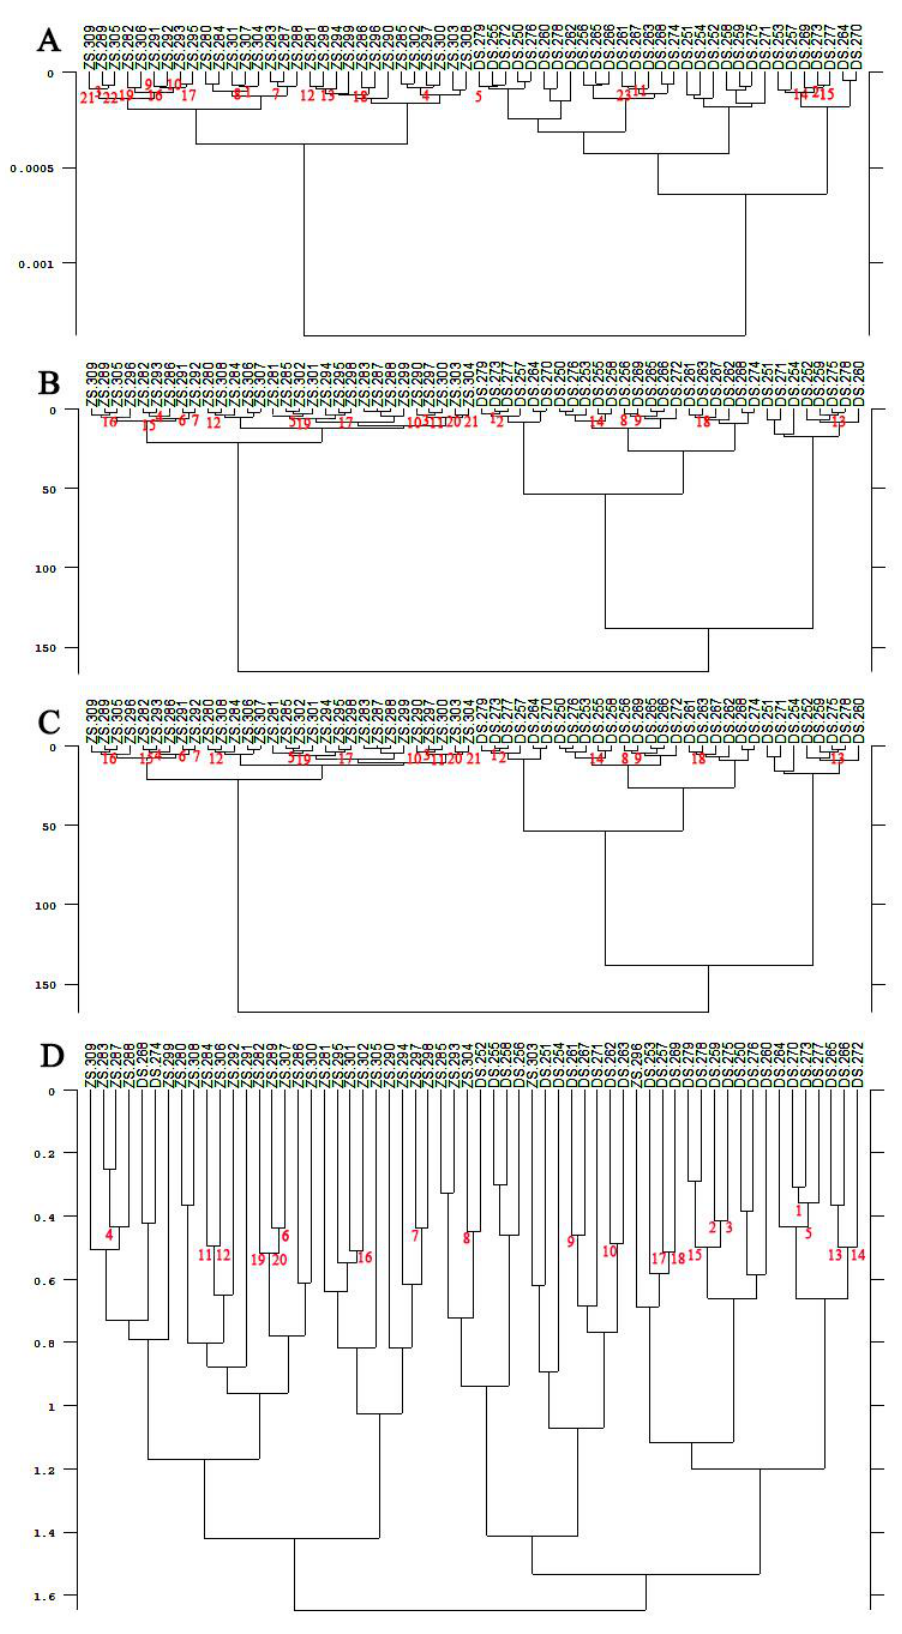
Figure 7. Cluster analysis tree diagram of pear fruit from the Horticulture Experimental Station of Northwest A&F University. ( A ) Standard algorithms; ( B ) First range calibration methods; ( C ) Reproduction level normalization methods; ( D ) Factorial methods.